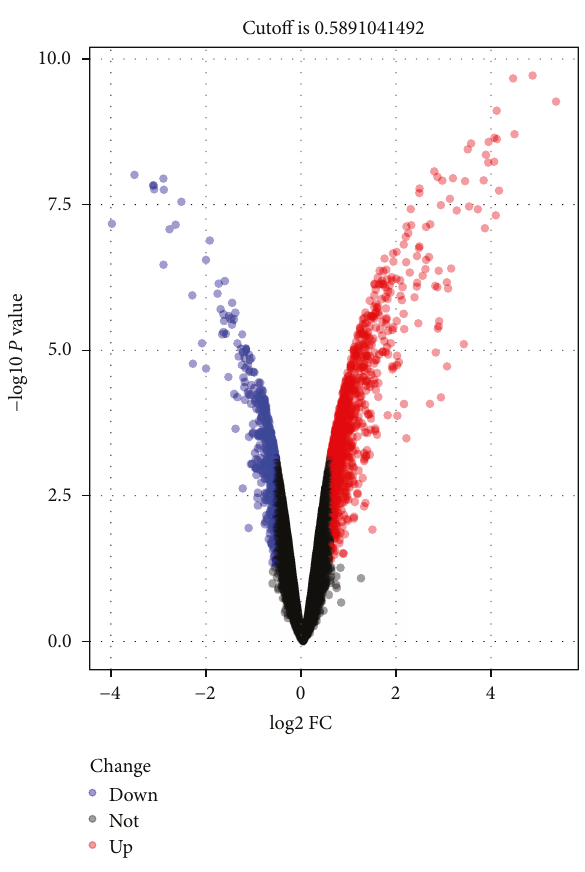
Figure 2: Volcano plot of detectable DEG pro fi les in BC cells. Red plots stand for upregulated genes, and blue ones represent downregulated genes with P < 0 05 and absolute log ones indicate those nonsigni fi cant expressed genes. The abscissa means the value of fold change in circulating the gene expression between BC cells and control. The ordinate shows the − log the adjusted P value for each gene, suggesting the strength of the association. DEGs: di ff erentially expressed genes; BC: bladder cancer; FC: fold